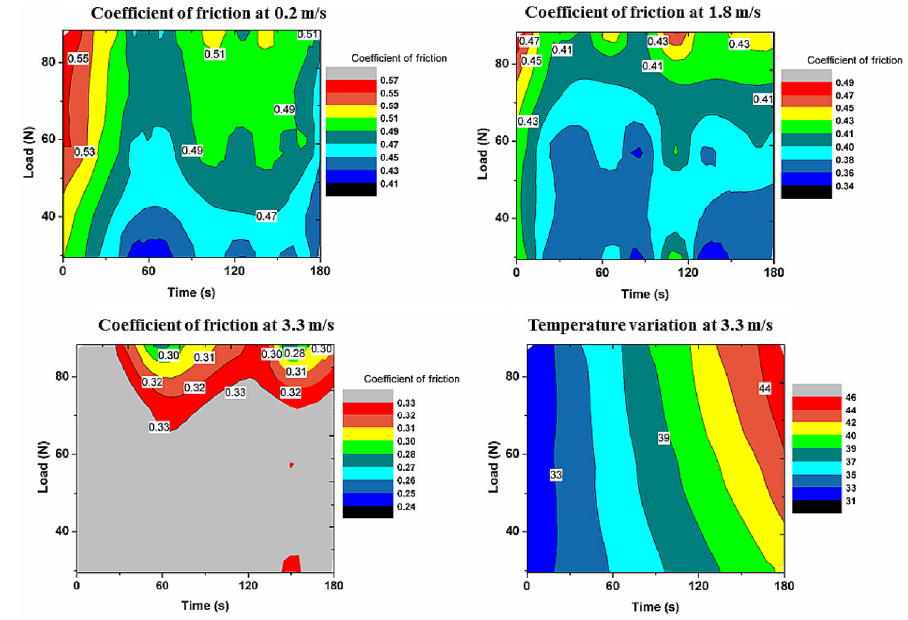
Fig. 8 Variation of the coefficient of friction and temperature for W-IV